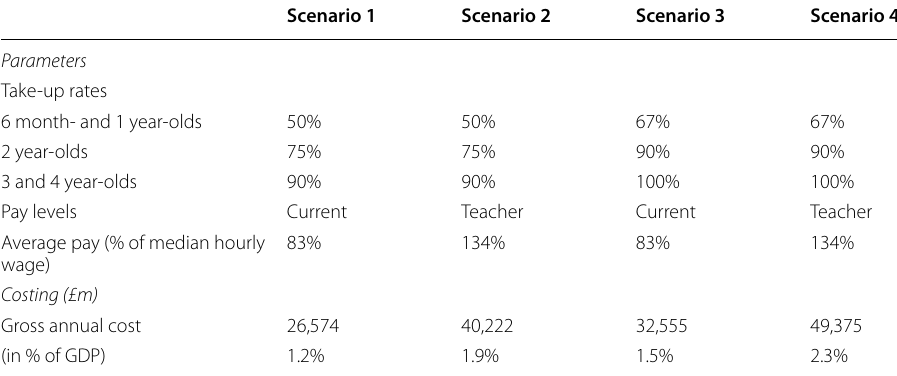
Table 3 Gross annual investment of universal childcare for different